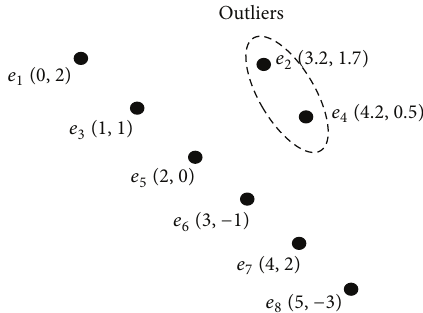
Figure 13: Characteristic line of a V-formation with two outliers.